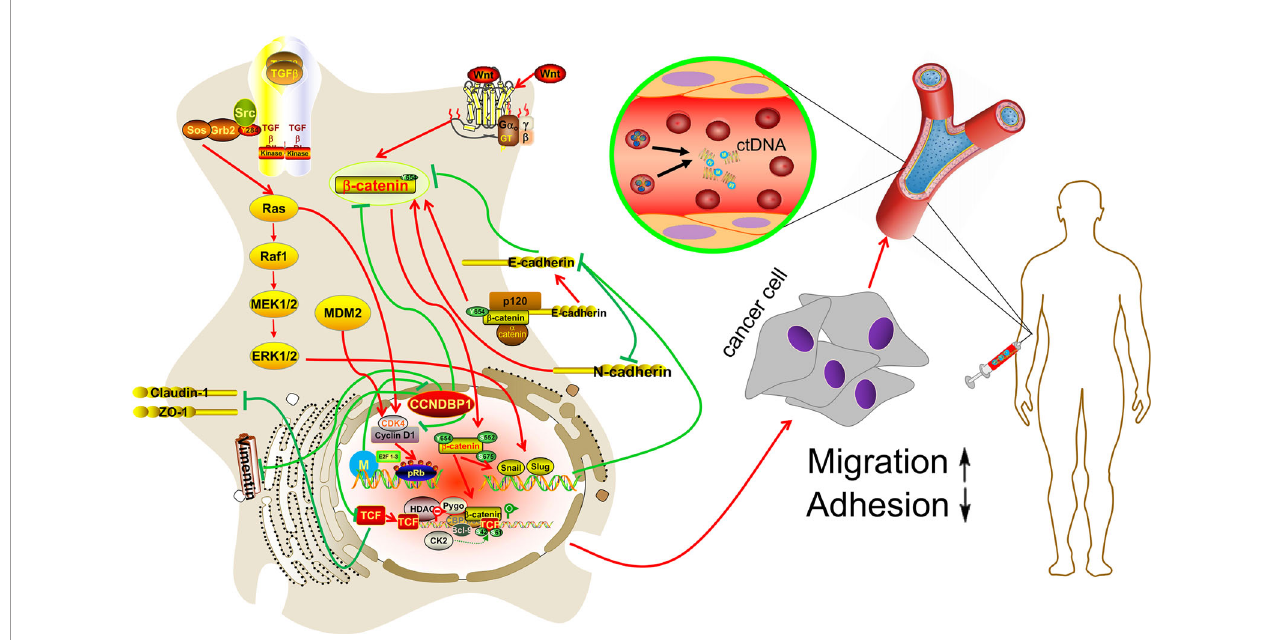
FIGURE 8 | Hypothetical model.CCNDBP1 could inhibitthemigration and invasion capacities of DDL by regulating the EMT process, which could beconductedby repressing a variety ofsignaling pathways, such as the Wnt/ b -catenin,Snail/Slug, TGF- b , and MAPK. In addition,the methylation site might bethe regulation of CCNDBP1 gene expression in DDL, which could drive future research, includingthe detection of the methylation level of CCNDBP1 inplasma ctDNA byliquid